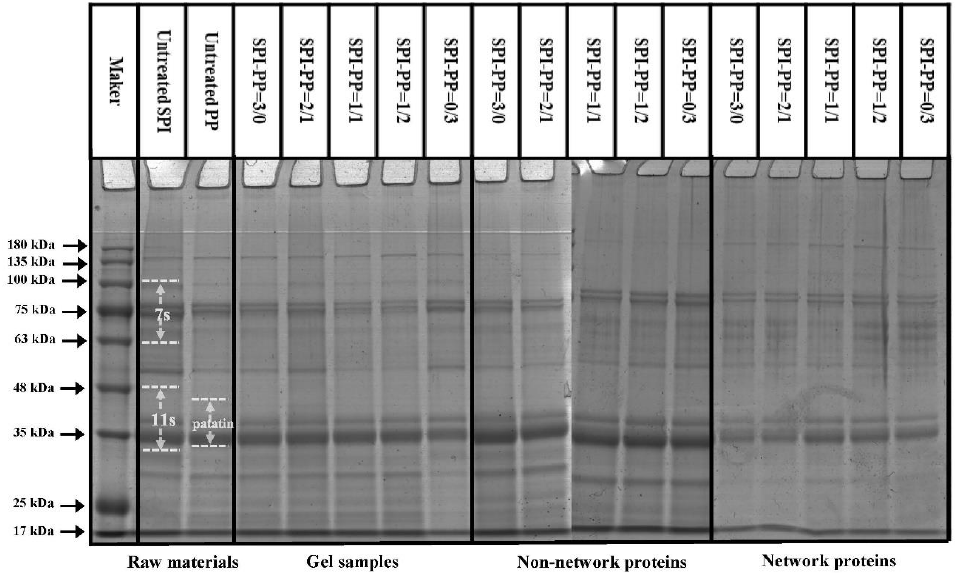
Figure 2. SDS-PAGE analysis of controls and composite gels, non-network proteins, and network proteins at different SPI and PP ratios.